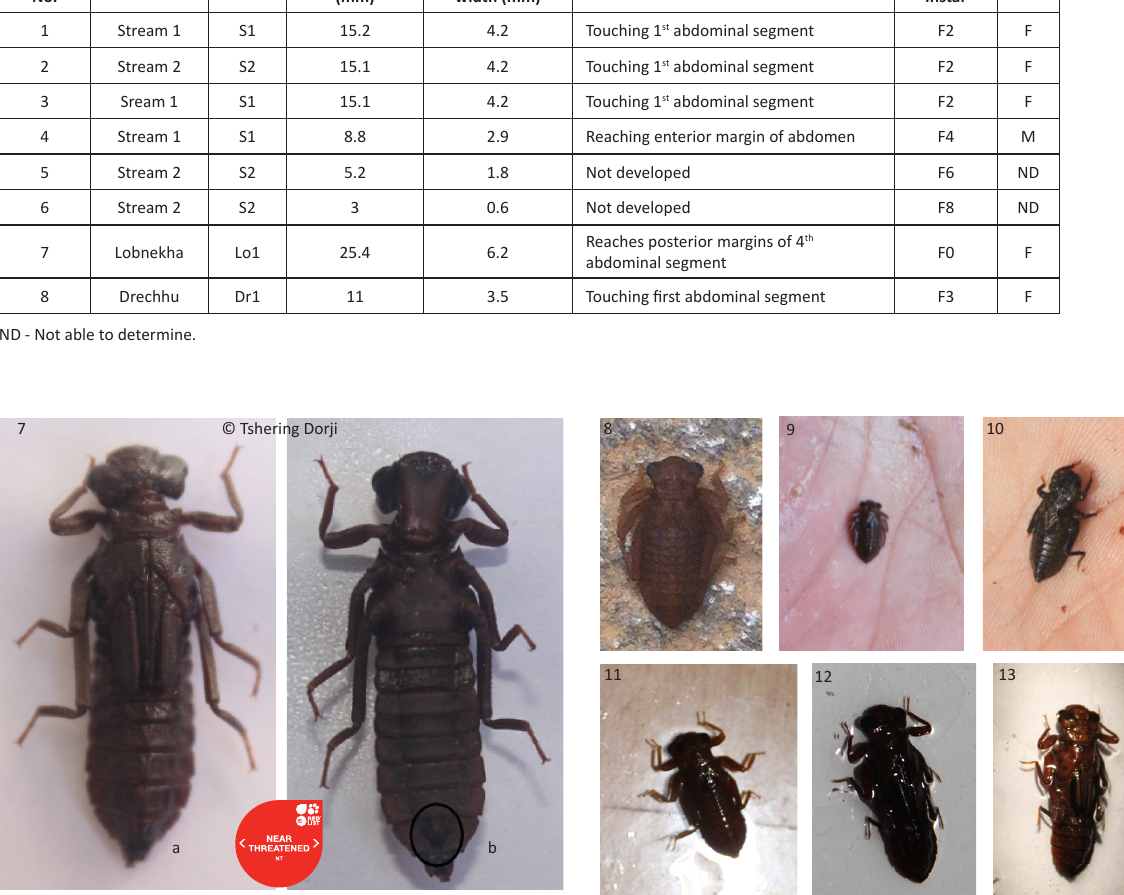
Table 2. Larval development stage with descriptions and sex of larva number 1–8. Larvae